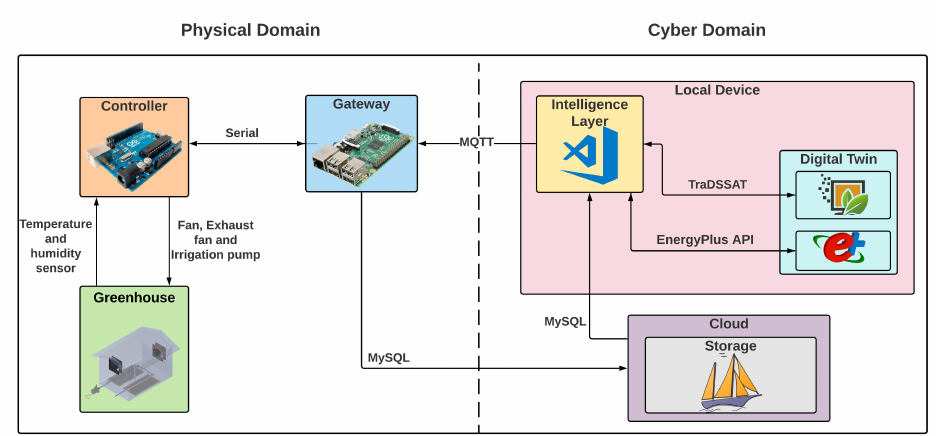
Figure 4. Framework and technologies utilized within the DT architecture for CEA